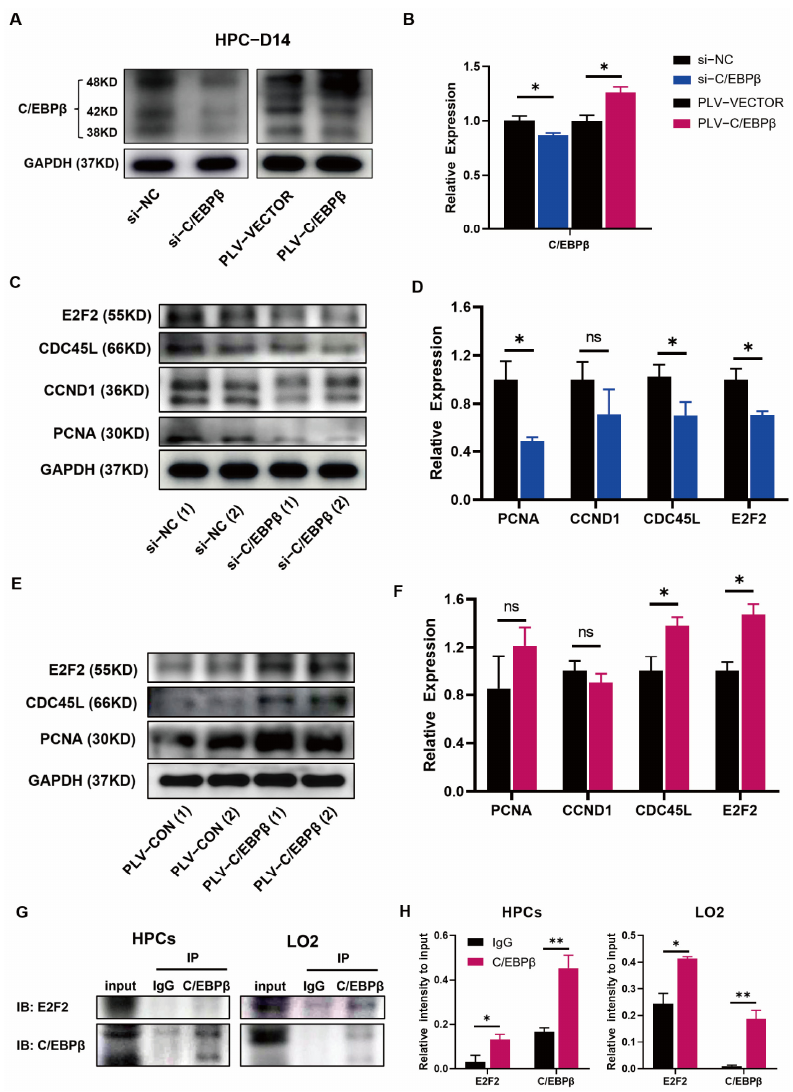
Figure 5. C/EBP β coupled with E2F2 orchestrated cell proliferation of HPCs. ( A , B ) Western blot analysis of C/EBP β on day 14 of HPCs after the knockdown or overexpression of C/EBP β ( A ), and the statistical results ( B ). ( C , D ) Western blot analysis of representative protein expressions associated with cell proliferation after knockdown of C/EBP β ( C ), and corresponding statistical results ( D ). ( E , F ) Western blot analysis of representative protein expressions associated with cell proliferation after overexpression of C/EBP β ( E ) and corresponding statistical results ( F ). ( G , H ) Co-immunoprecipitation (Co-IP) assays to validate interaction of C/EBP β with E2F2 in HPCs on day 14 and LO2 cells. The cell lysates were subjected to immunoprecipitation with C/EBP β antibody, and the resulting immunoprecipitants were analyzed in the immunoblot with E2F2 and C/EBP β antibodies (IB: E2F2; IB: C/EBP β ). Input was also subjected to immunoblot to represent a positive control, and non-specific IgG represented as a negative control. Data represent mean ± SEM with p -values indicated when significant. p < 0.05 *, p < 0.01 **, ns, not significant. Data are the three samples per